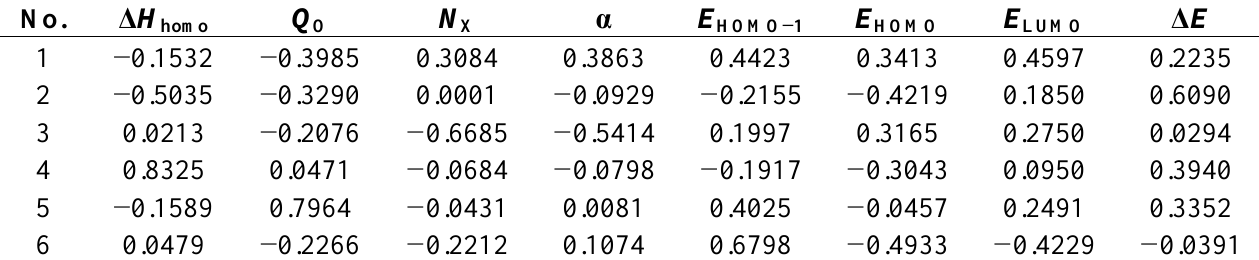
Table 5. First six principal components of the weight coefficients and the corresponding molecular